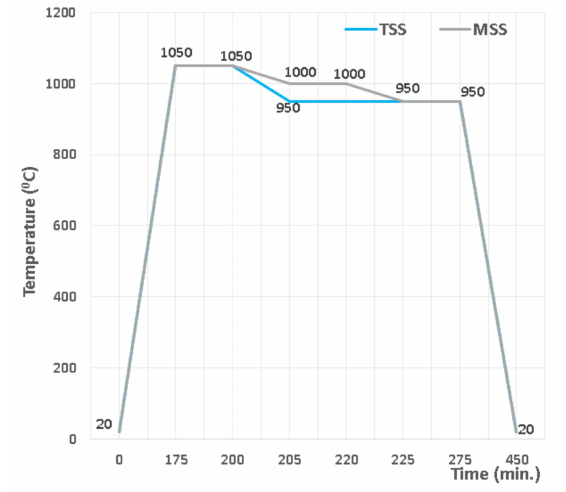
Figure 1. Sintering processes flow